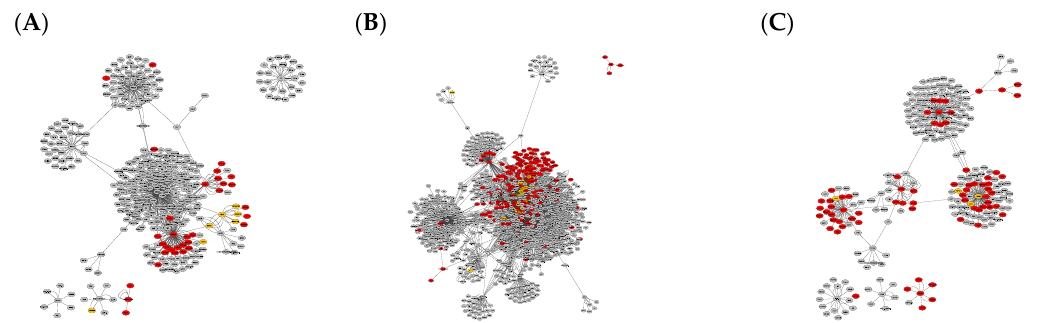
Figure 1. Graph clusters from BioGRID showing unique difference networks between the intersection of all three disease-type constructed networks and each type-specific network with ( A ) general glioma, ( B ) glioblastoma multiforme and ( C ) low-grade astrocytoma. Graphs were rendered with Prefuse Force Directed Layout, clustered by ClusterOne (grey: outlier, yellow: overlap, red: cluster).